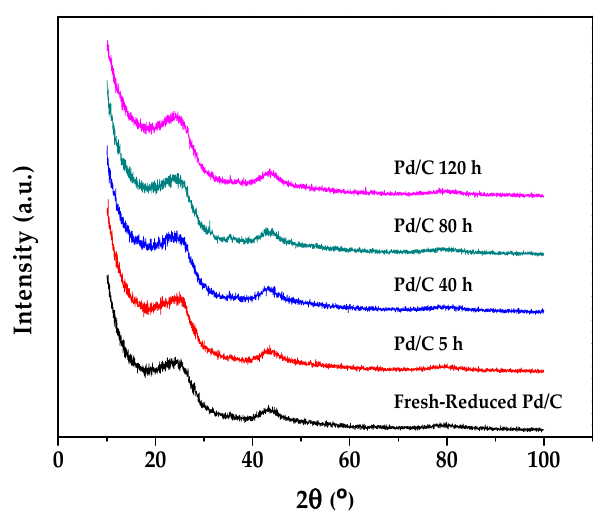
Figure 4. X-ray di ff raction (XRD) patterns of Pd / C used in the HDC of DCM for 5 h, 40 h, 80 h and Figure 4. X-ray diffraction (XRD) patterns of Pd/C used in the HDC of DCM for 5 h, 40 h, 80 h and 120 h. 120 h. Table 3. XPS results in relative atomic composition in the two studies (experiments at di ff erent time